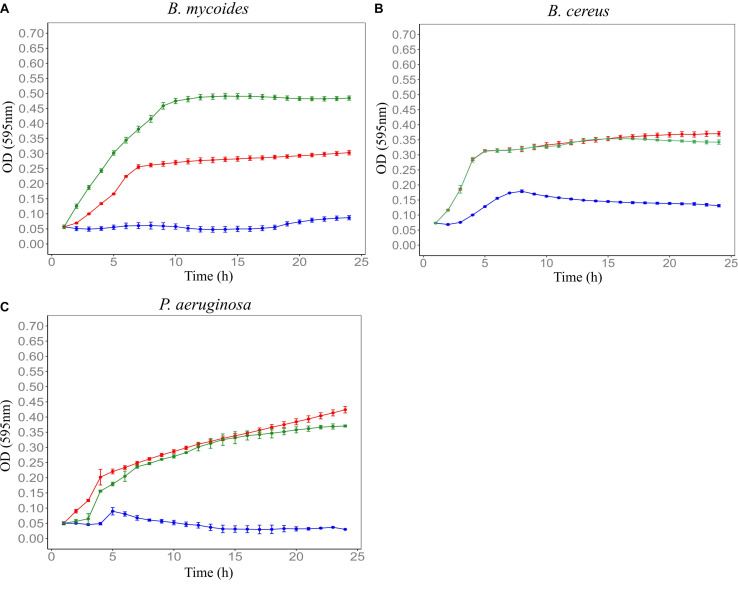
Involvement of Clostridium spp. isolated from Farm 4 soil in F4SCM’s antimicrobial activity. CMs were prepared from sterile Farm 4 soil (F4SCMSterile) and Farm 4 soil spiked with Clostridium spp. (F4SCMSpiked) and evaluated their antimicrobial activities against B. mycoides ATCC 6462 (A), B. cereus NZRM 5 (B), and P. aeruginosa ATCC 25668 (C). Bacteria were grown in the presence of butterfield’s diluent (red), F4SCMSterile (green), and F4SCMSpiked (blue). Each curve represents the mean growth rate ± S.D (n = 3). F4SCMSpiked significantly inhibited the growth of all three tested microorganisms while F4SCMSterile showed no antimicrobial activity (p < 0.05 vs. untreated control/butterfield’s diluent).